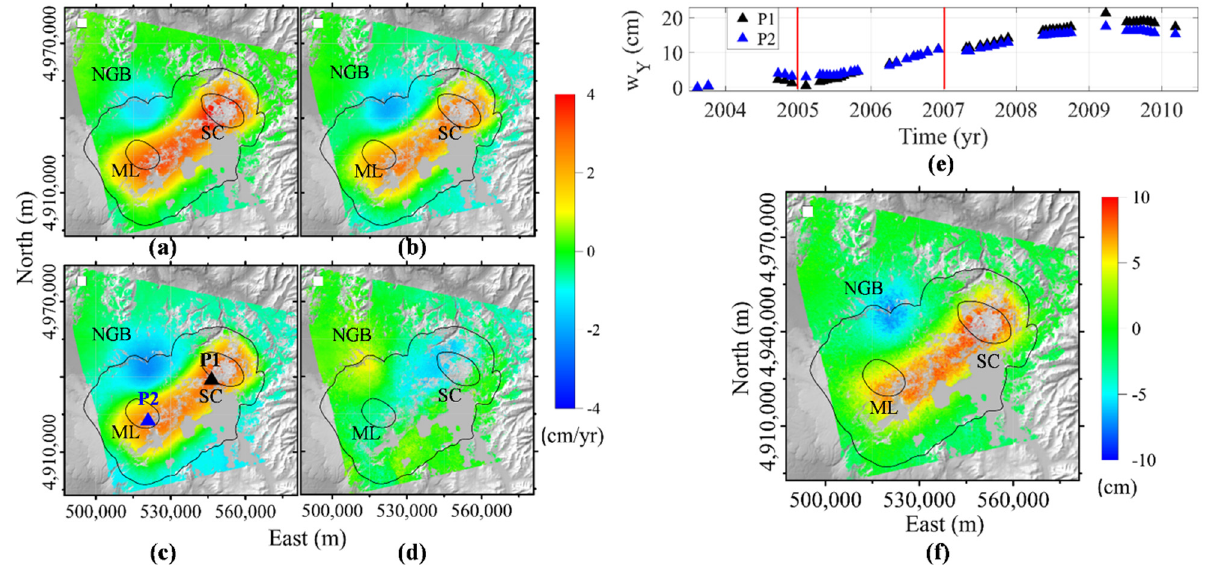
Figure 2. ENVISAT InSAR measurements at Yellowstone caldera. Maps of the mean ( a ) ascending, ( b ) descending, ( c ) vertical, and ( d ) E − W velocity component of deformation between 2003.5 and 2010. Black and blue triangles indicate the positions of P1 and P2 pixels. ( e ) Time series of vertical deformation ( w Y ) at P1 and P2 pixels; the red lines point out the selected period for analysis, 2005 − 2007. ( f ) Cumulative vertical deformation during the 2005 − 2007 interval. The black lines delineate the boundaries of the caldera, Mallard Lake (ML), and Sour Creek (SC) resurgent domes, whereas NGB is the Norris Geyser Basin; the white square represents the InSAR reference pixel location. The maps are plotted on top of the SRTM-DEM of the area. UTM-WGS84 projection zone: 12N. All the maps are generated by using software Surfer ® 16 (http://www.goldensoftware.com/products/surfer (accessed on 1 November 2021)).